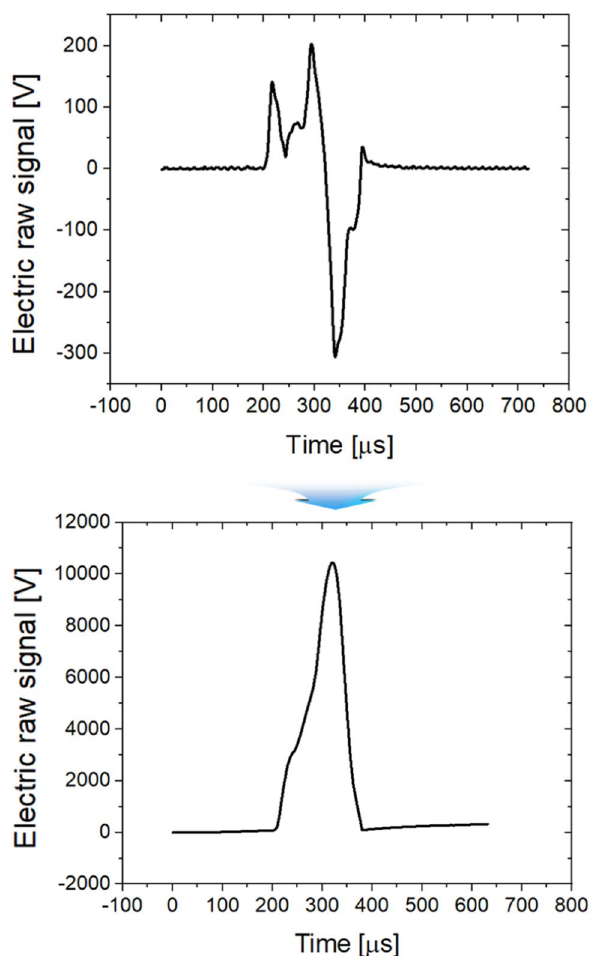
Figure 11. Conversion of sensor signal into load graph